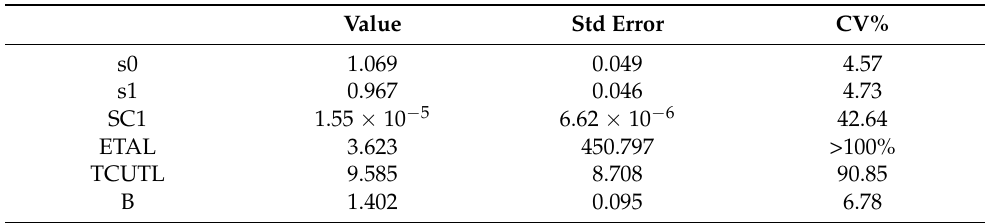
Figure 14. Predicted (solid line) and experimental (dots) montelukast plasma levels representing the one-step level-A IVIVC developed with 4 formulations. Table 8. Parameters (and their standard error and coefficient of variation) of the IVIVC developed with 4 formulations.